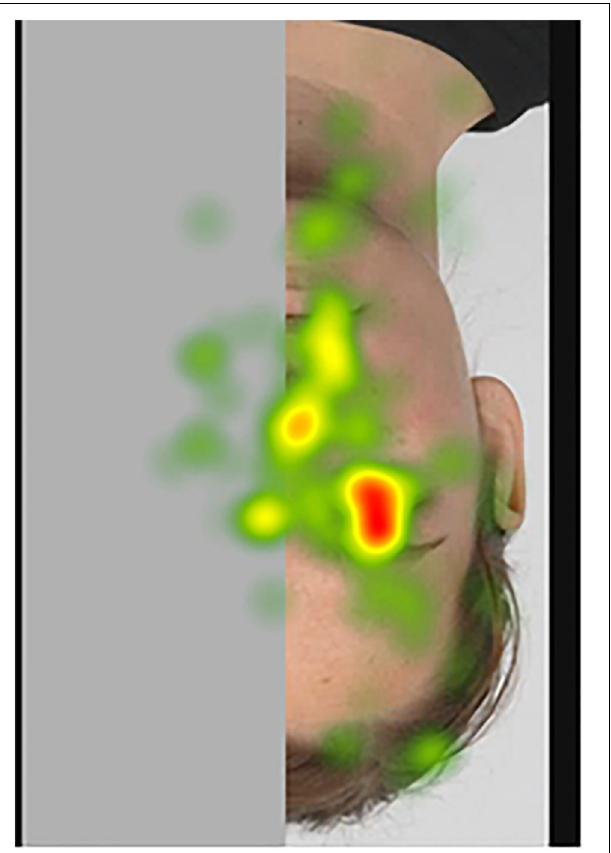
FIGURE 6 | Fixation heatmap of a left inverted stimulus.